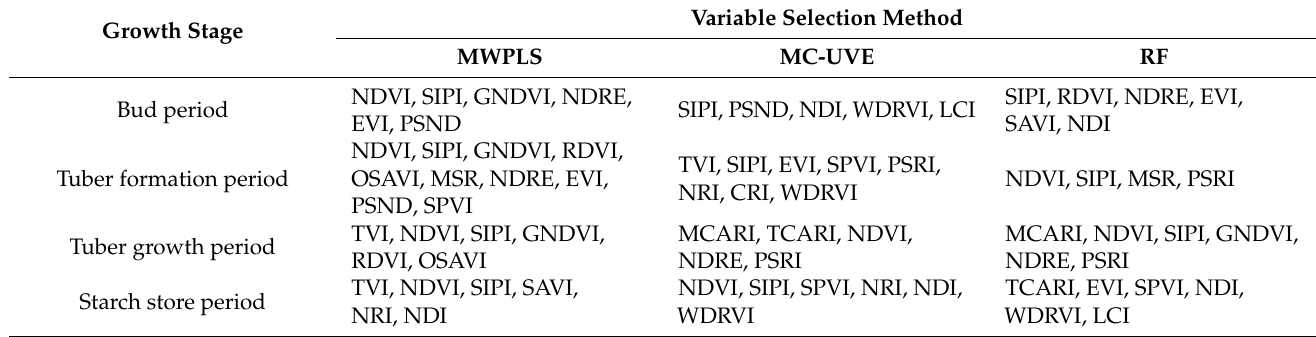
Table 4. Vegetation indexes of AGB estimation model were selected by the MWPLS, MC-UVE, and RF methods for each growth period.